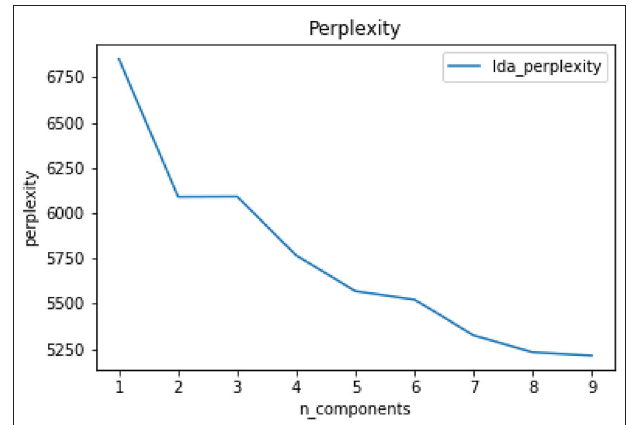
FIGURE 4 | Calculation of